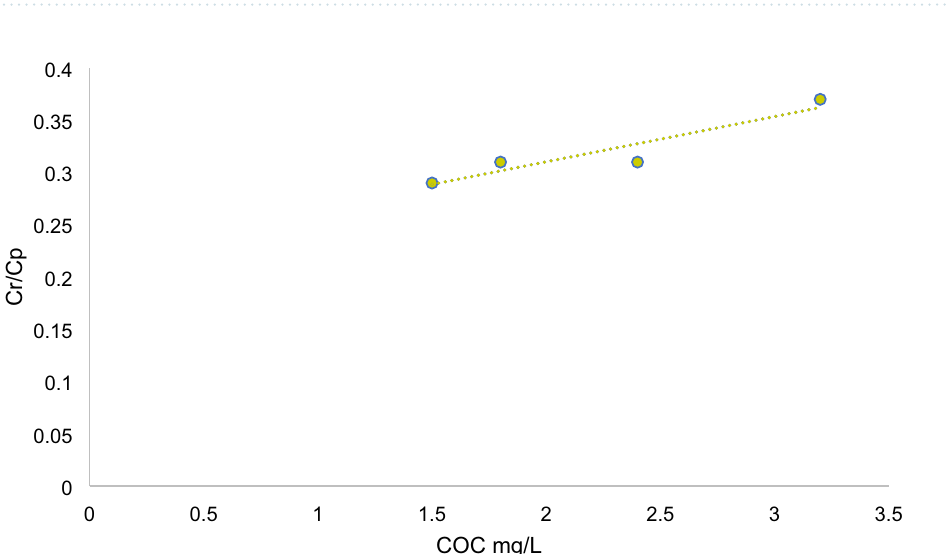
Figure 9. Enhanced capacity in river water samples separated by three filters (1.2 µm, 0.7 µm and 0.2 µm).